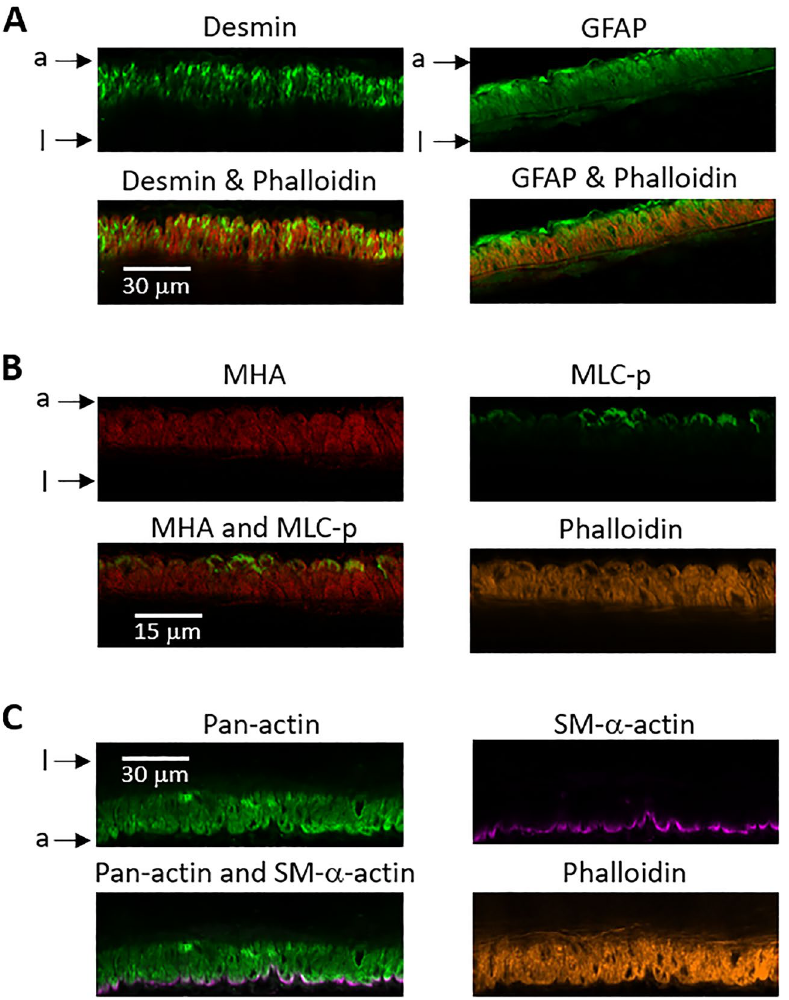
Figure 2. The pattern of MLC-p and SMA-α-actin staining is not due to limited antibody diffusion across the vessel wall. ( A ) Immuno-staining of desmin (green) and GFAP (green) in the vessel wall of rat SCA. Vessel was fixed while maintaining a stable myogenic tone at 70 mmHg. ( B ) Triple staining of myosin heavy chain type A (MHA, red), MLC-p (green) and phalloidin (yellow) in the vessel wall of SCA. ( C ) Triple-staining of pan-actin (green), SM-α-actin (purple) and phalloidin (yellow) in the vessel wall of SCA. a: depicts adventitia side of vessel wall; l: depicts intra-luminal side of vessel